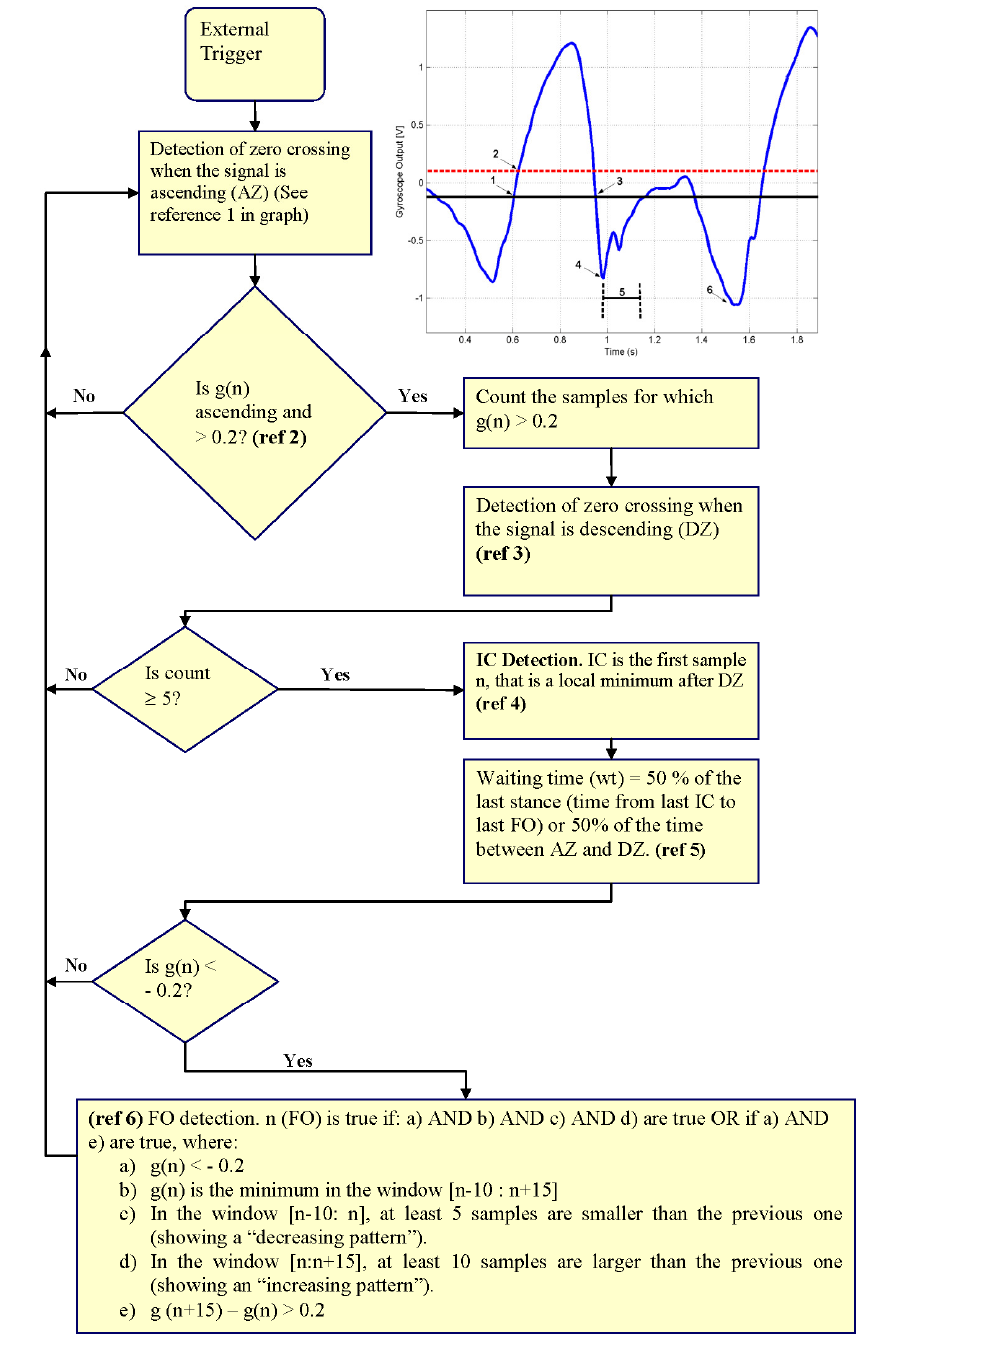
Figure 3. Flowchart of the algorithm used for detection of Initial Contact (IC) and Foot Off (FO) from the gyroscope signal. The graph corresponds to data collected from one subject who participated in the study. g(n) is the value of the gyroscope signal at the sample n; AZ: ascending zero crossing; DZ: descending zero crossing; and wt: waiting time. The numbers in the graph relate to steps of the algorithm: (1) detection of ascending zero crossing; (2) detection of signal exceeding threshold of 0.2 V; (3) detection of descending zero crossing; (4) IC detection; (5) waiting time; and (6) FO detection. After FO detection, the algorithm starts